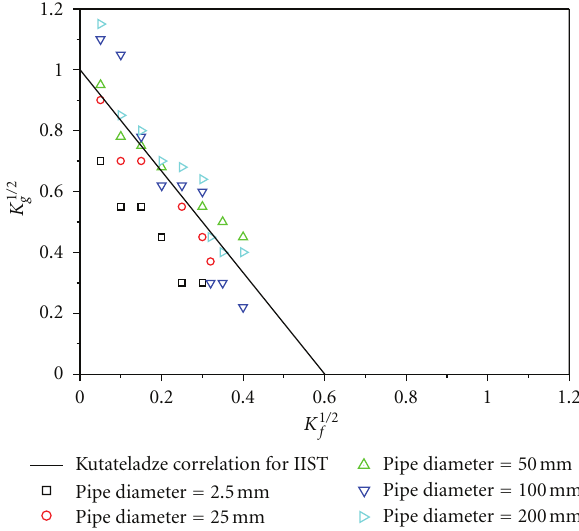
Figure 3: The Kutateladze correlation comparison with data (pipe diameter = 2.5–200 mm).